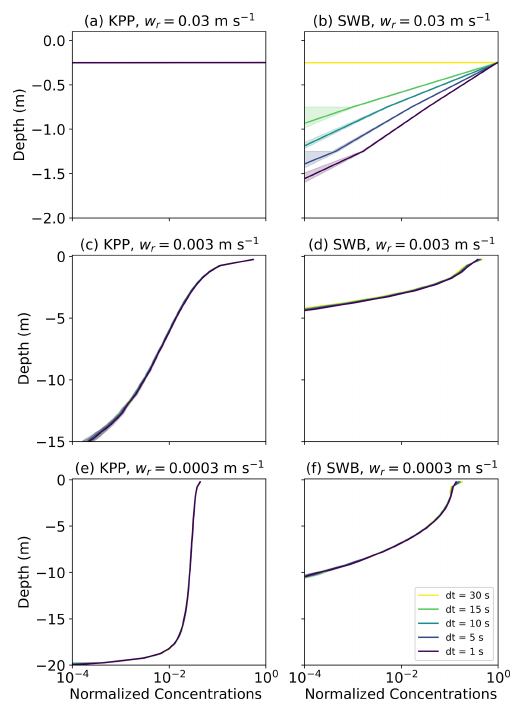
Figure F1. Vertical concentrations of buoyant particles for (a, c, e) KPP and (b, d, f) SWB diffusion using M-0 models with varying values for w rise and (cid:49)t ∈ [ 30 , 15 , 10 , 5 , 1 ] s. All profiles are for u 10 = 6 . 65ms − 1 . Shading around the profiles indicates the profile’s standard deviation at each depth level. The KPP profiles are computed with θ = 1 . 0 and z 0 according to Eq. (12), while the SWB profile is computed with γ = 1 .